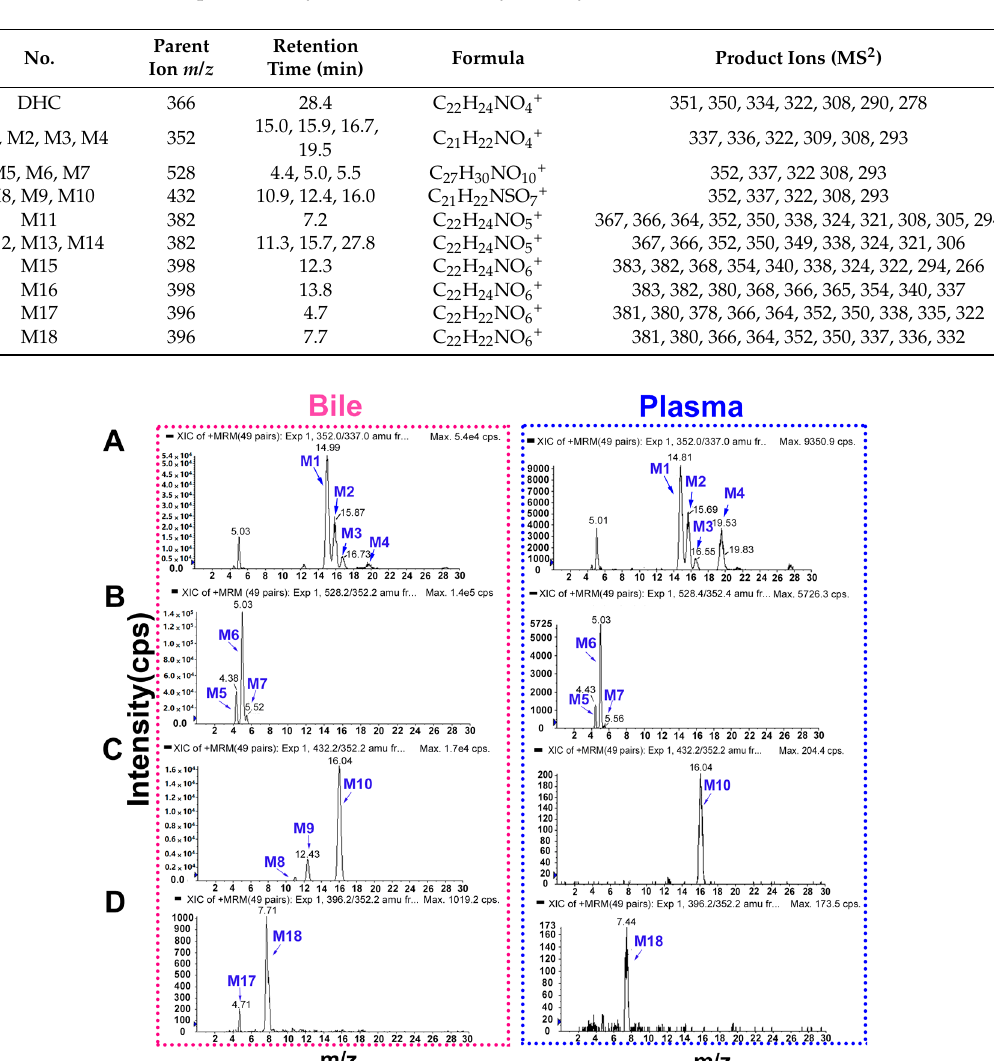
Table 1. Mass spectrometry (MS 2 ) data of dehydrocorydaline (DHC) and its metabolites.